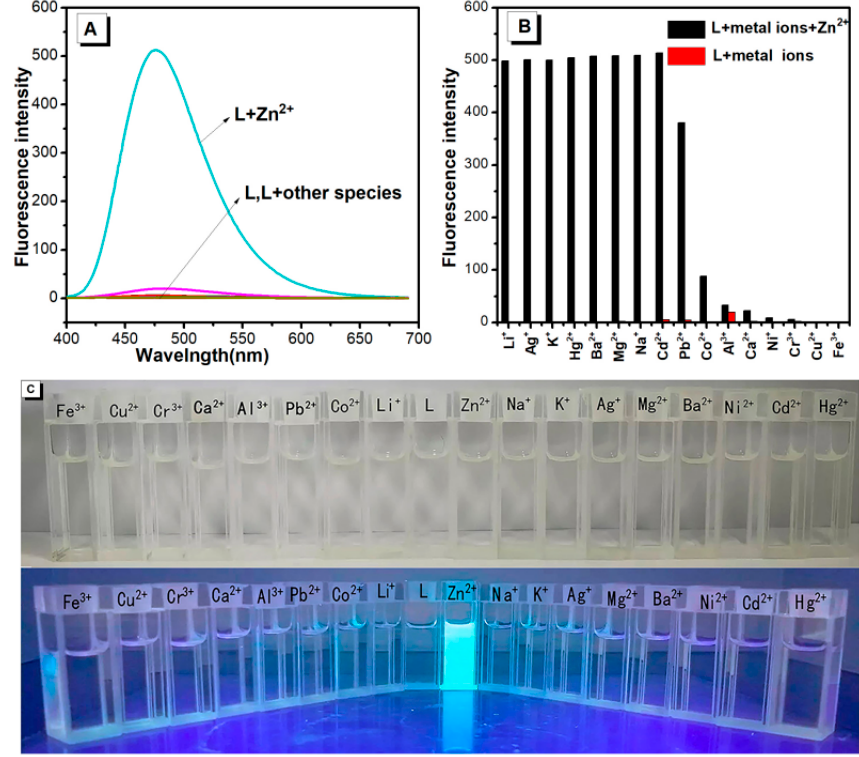
Figure 1. ( A ) Fluorescence spectra of L (50 μ mol/L) and upon the addition of salts (1 equiv.) of Li + , Na + , K + , Ag + , Mg 2+ , Ca 2+ , Ba 2+ , Al 3+ , Fe 3+ , Co 2+ , Ni 2+ , Cu 2+ , Zn 2+ , Pb 2+ , Cd 2+ , Hg 2+ , and Cr 3+ in CH 3 CH 2 OH. ( B ) Black bar: Relative fluorescence of L with 1 equiv. of metal ions stated; Red bar: Relative fluorescence of L and 1 equiv. of Zn 2+ with 1 equiv. of metal ions stated (E ex = 354 nm, E em = 475 nm). ( C ) Photos of L responding to 17 kinds of other metal ions and Zn 2+ under visible light (above) and UV light (below).